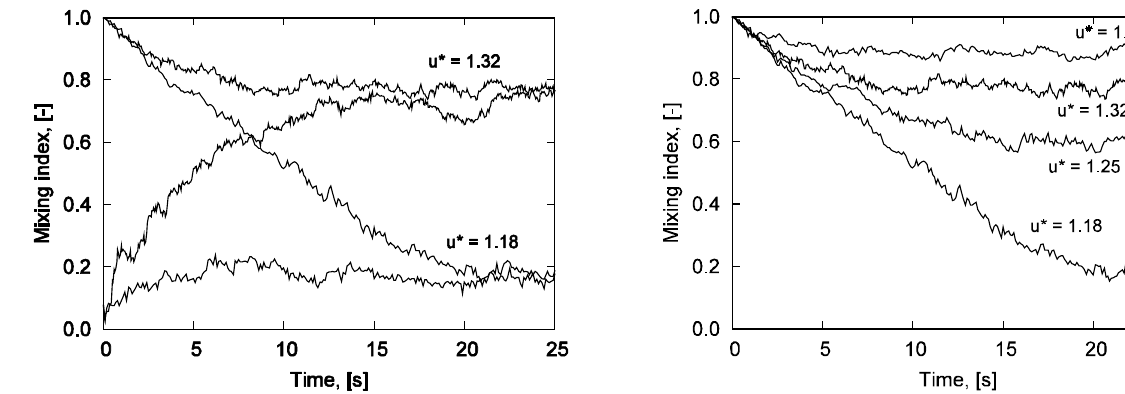
Fig. 2 Evolution of the degree of mixing from initially mixed ( MI ≈ 1) and segregated ( MI ≈ 0) configuration at the two dimensionless velocities indicated. Simulation conditions are reported in Table 2 .